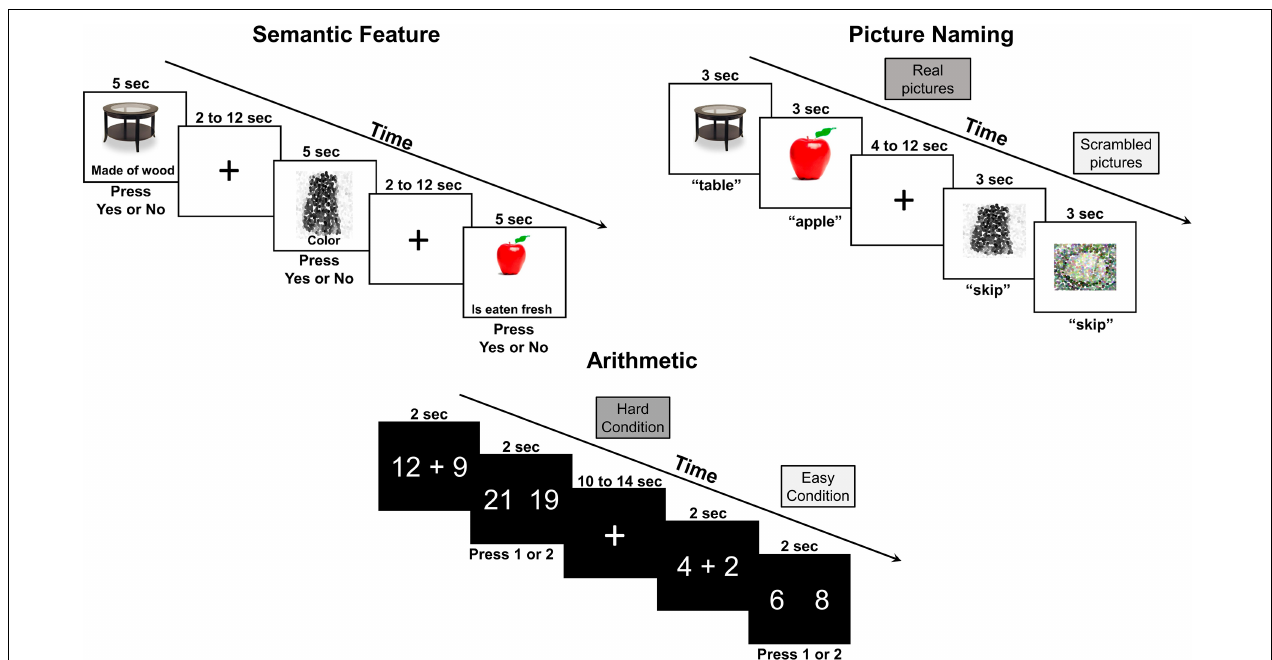
FIGURE 1 | Functional near-infrared spectroscopy behavioral